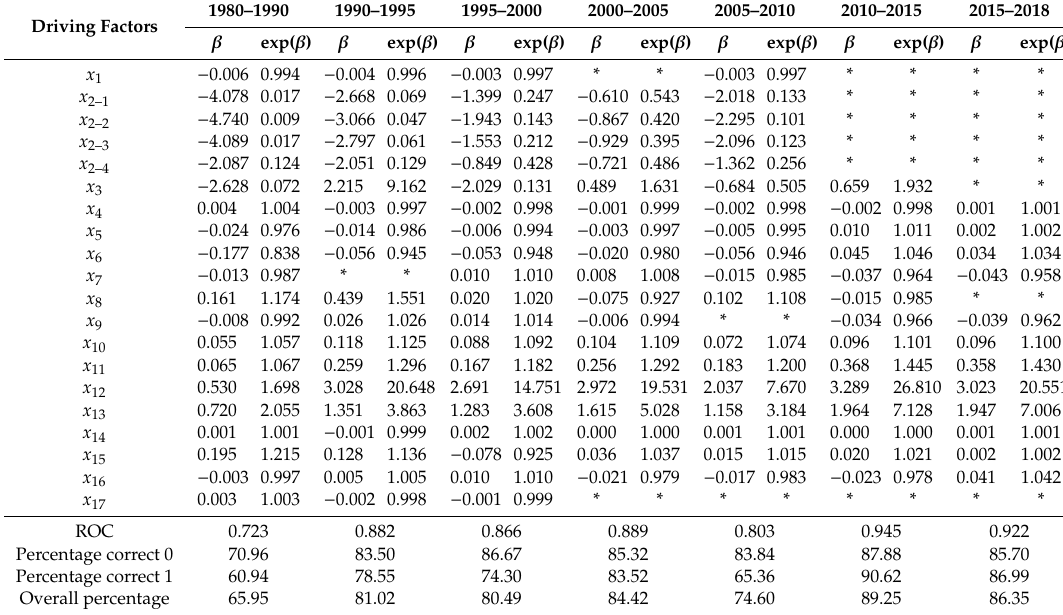
Table 2. Logistic regression results of cultivated land change in seven time